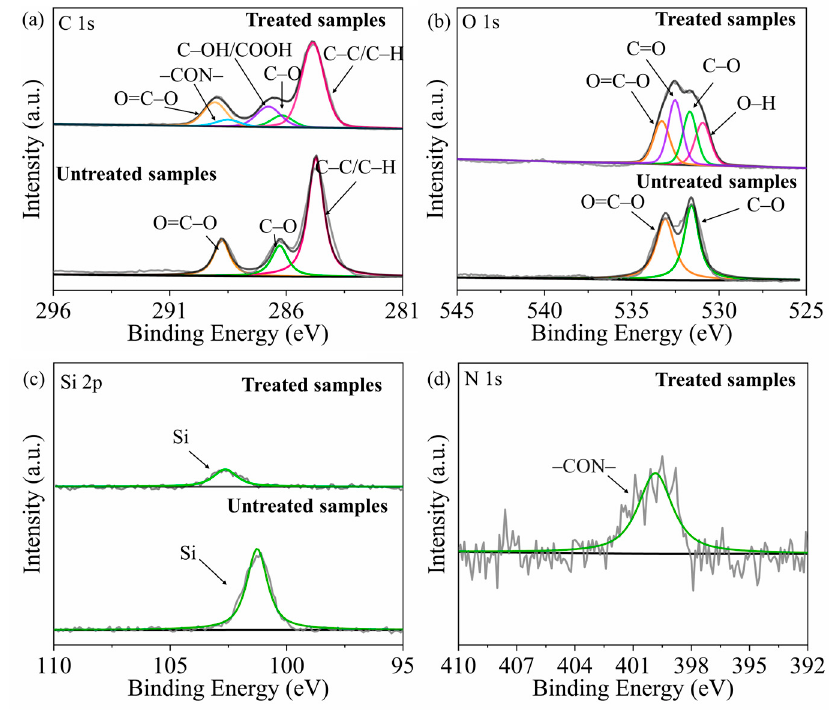
Figure 6. XPS analysis map, including different elements’ bonds pre- and post-plasma treatment: